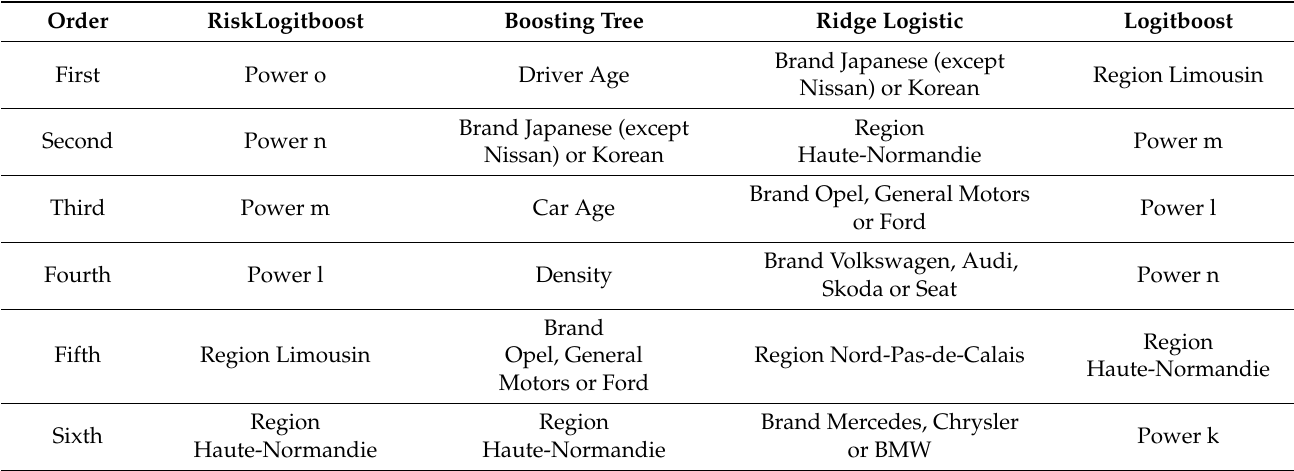
Table 4. Variable importance of the six most relevant covariates according to RiskLogitboost, Boosting Tree, Ridge Logistic regression and